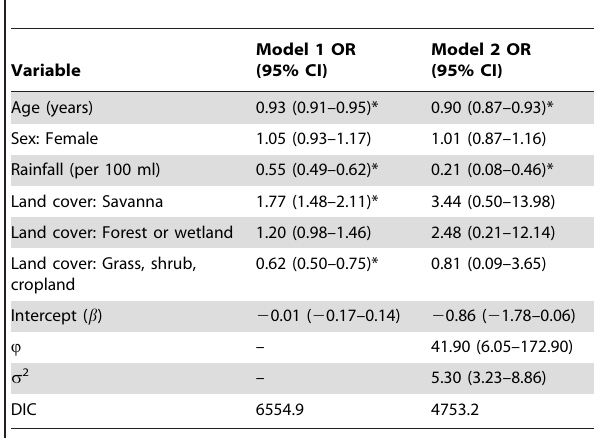
Table 2. Logistic regression models for active trachoma in children aged 1–9